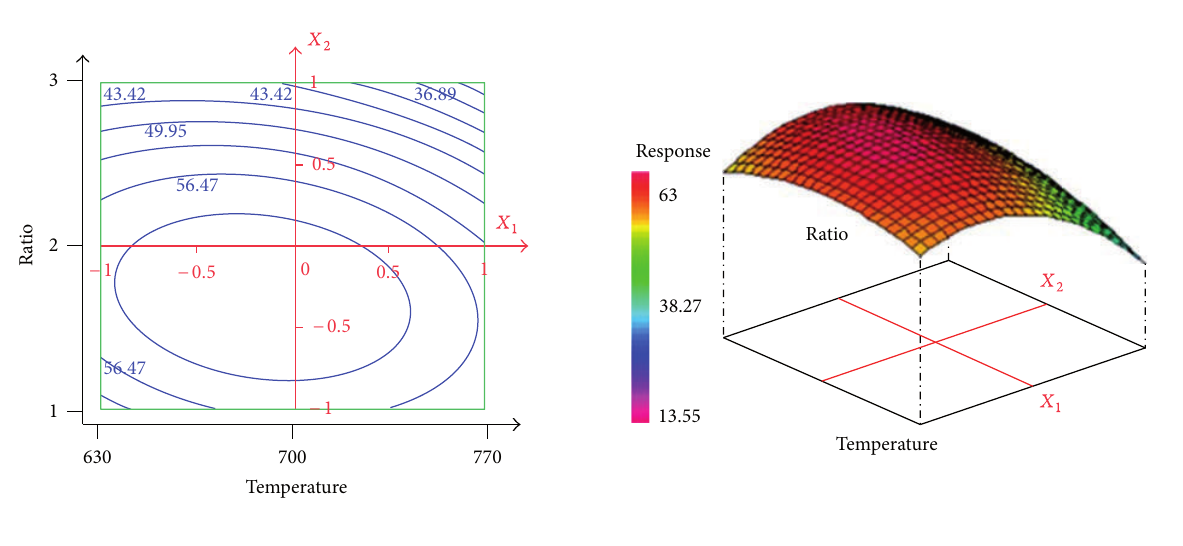
F 1: Variation of the activated carbon yield (